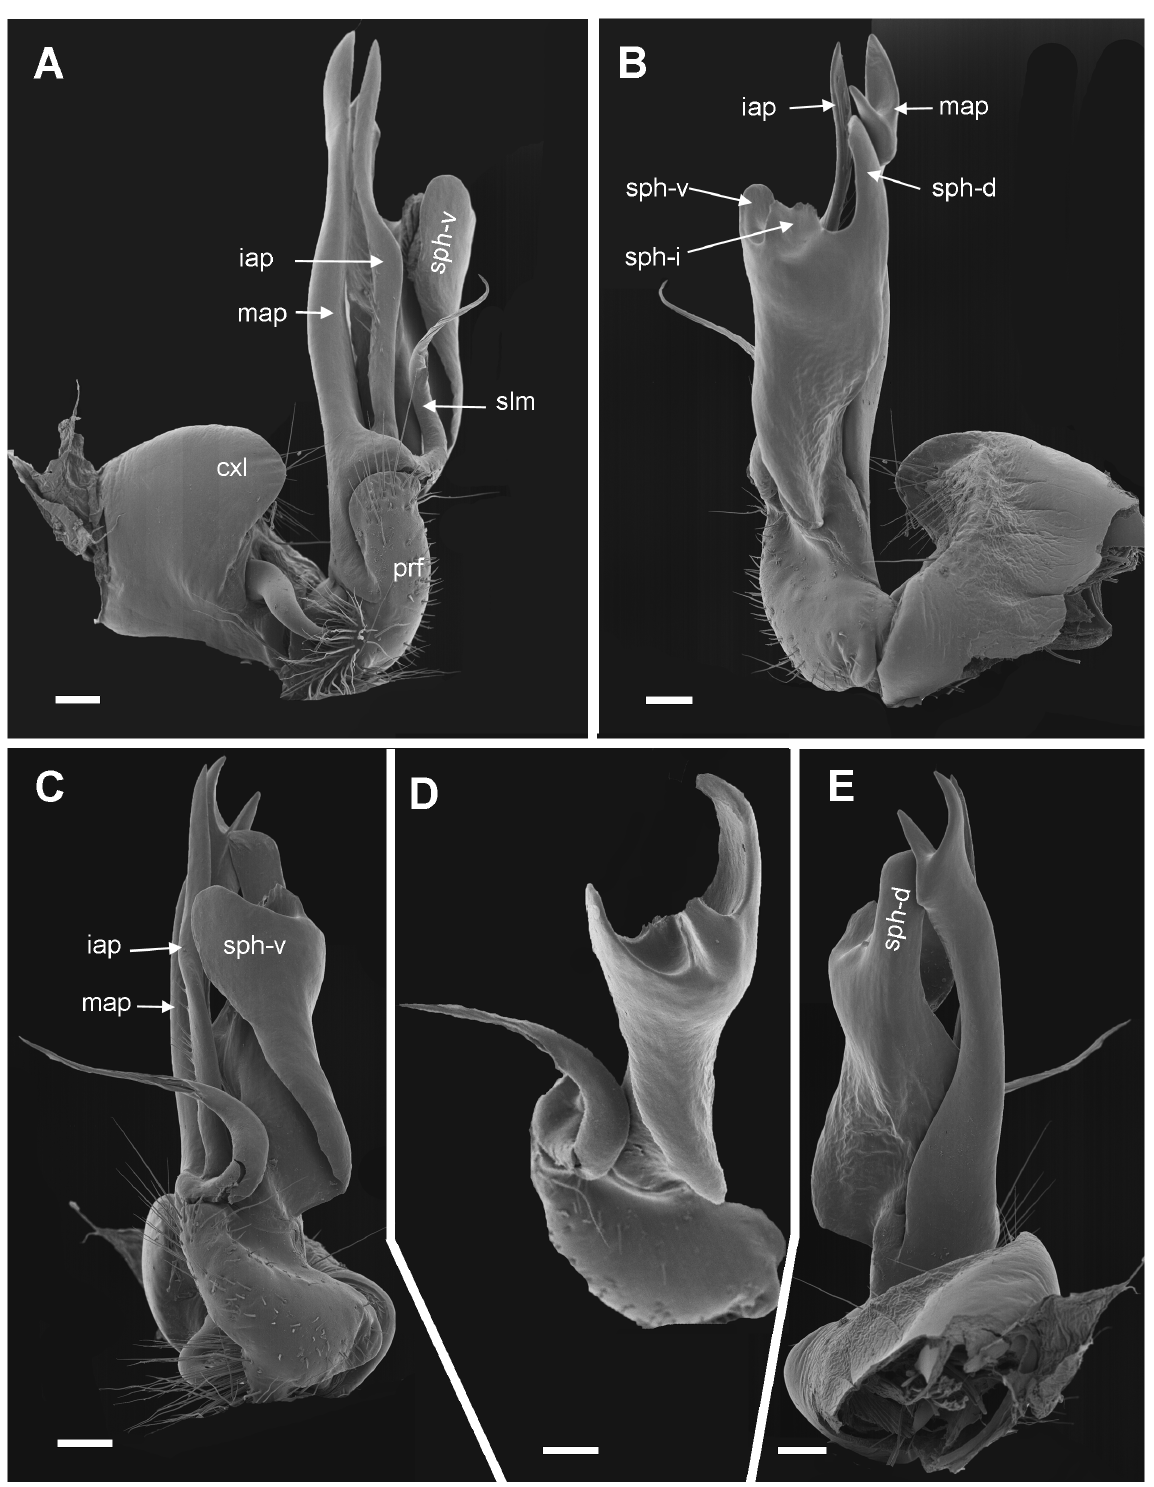
Fig. 20. Eviulisoma ottokrausi sp. nov, paratype, left gonopod. A . Mesal view. B . Lateral view. C . Ventral view. D . Acropodite, latero-ventro-apical view. E . Dorsal view. Abbreviations: cxl = coxal lobe; iap = intermediate acropodital process; map = mesal acropodital process; prf = prefemoral part; slm = solenomere; sph-d , sph-i , sph-v = dorsal, intermediate and ventral lobes of solenophore. Scale bars: A–D = 0.1